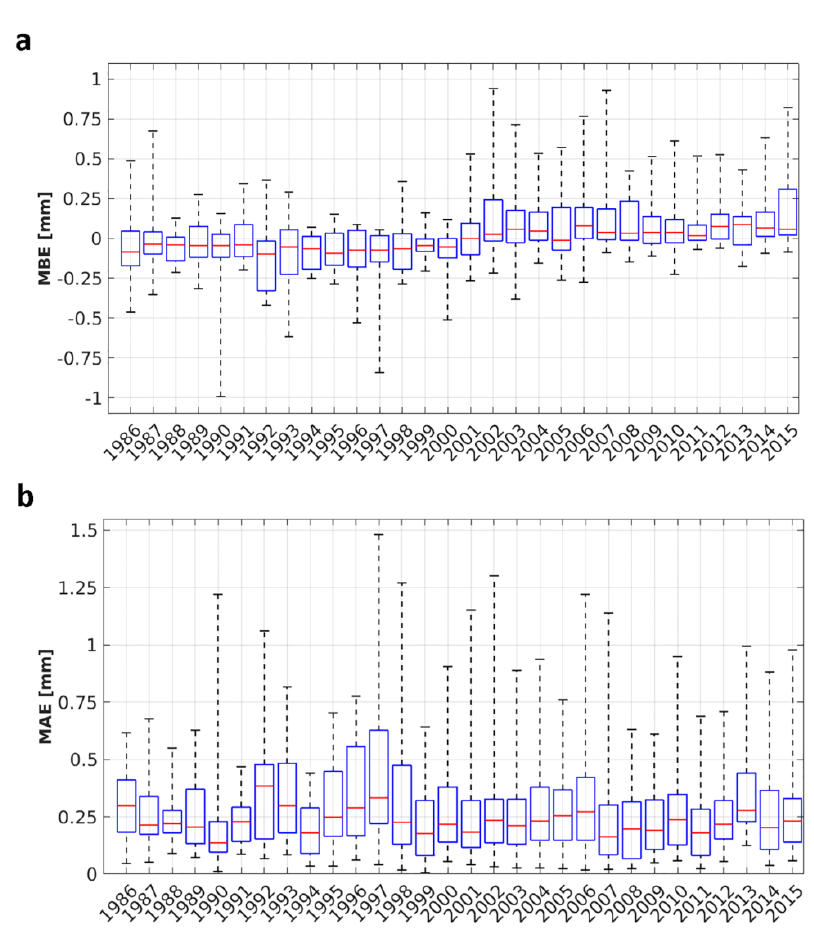
Figure 5. ( a ) MBE and ( b ) MAE annual variation between modeled and station precipitation data. Central red marks display the median, box edges display the range between the 25th and 75th percentiles and the whiskers point to the minimum and the maximum values, respectively.